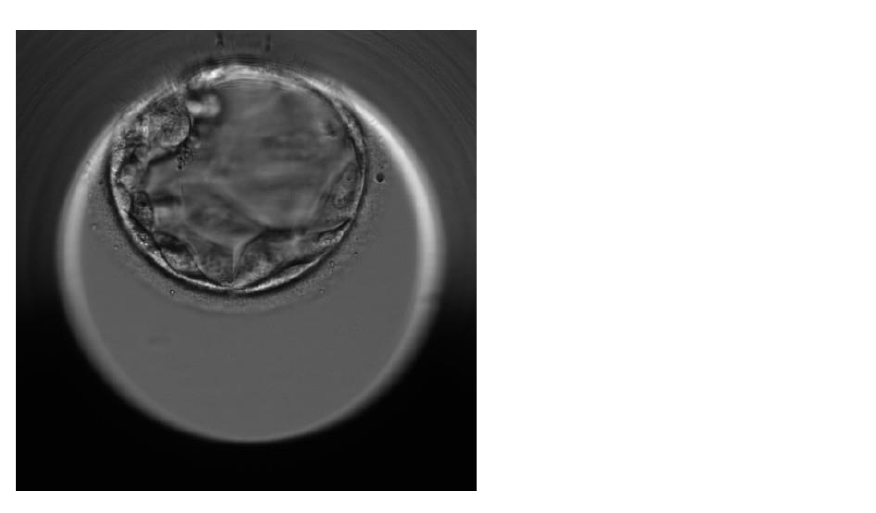
Figure 2. Embryoscope picture of the tested euploid day-5 embryo (blastocyst) that was transferred in a frozen-thawed cycle with endometrial preparation.